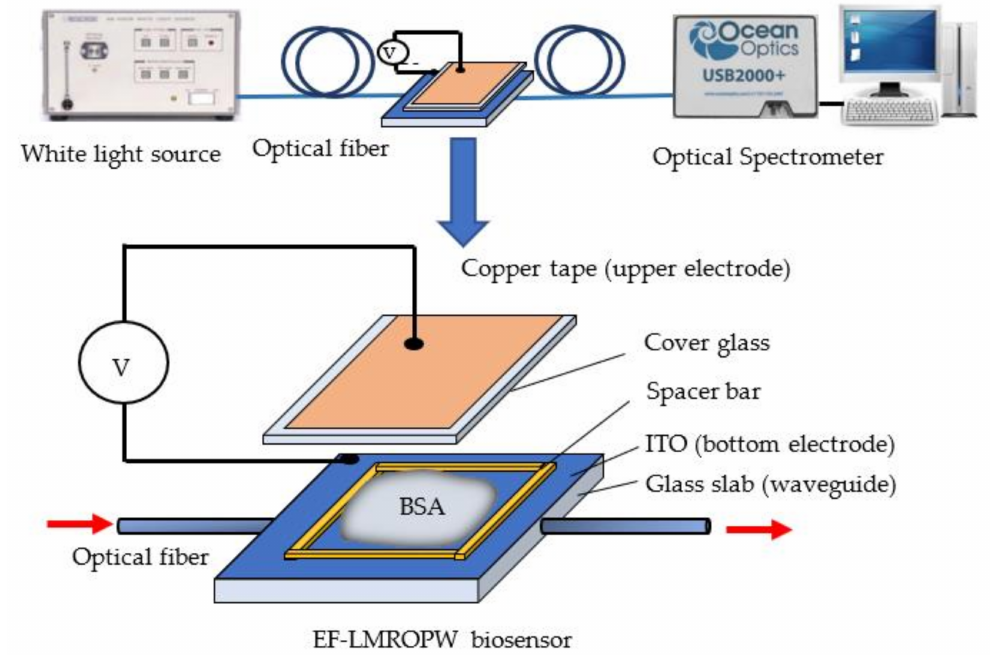
Figure 1. A schematic diagram of the experimental set-up and a photograph of the electrical field- induced lossy mode resonance-based optical planar waveguide (EF-LMROPW) sensor with the optical alignment